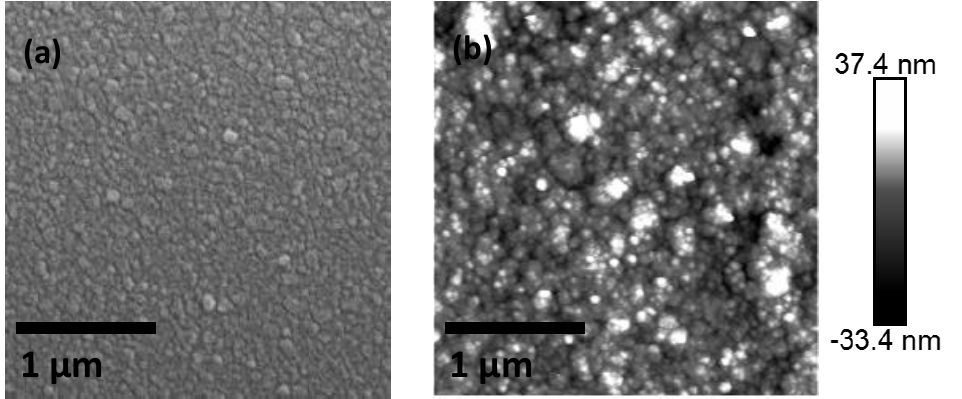
Figure 11. Images of 700 °C conditioned fibres obtained using ( a ) Scanning Electron Microscopy (SEM) and ( b ) Atomic Force Microscopy (AFM).